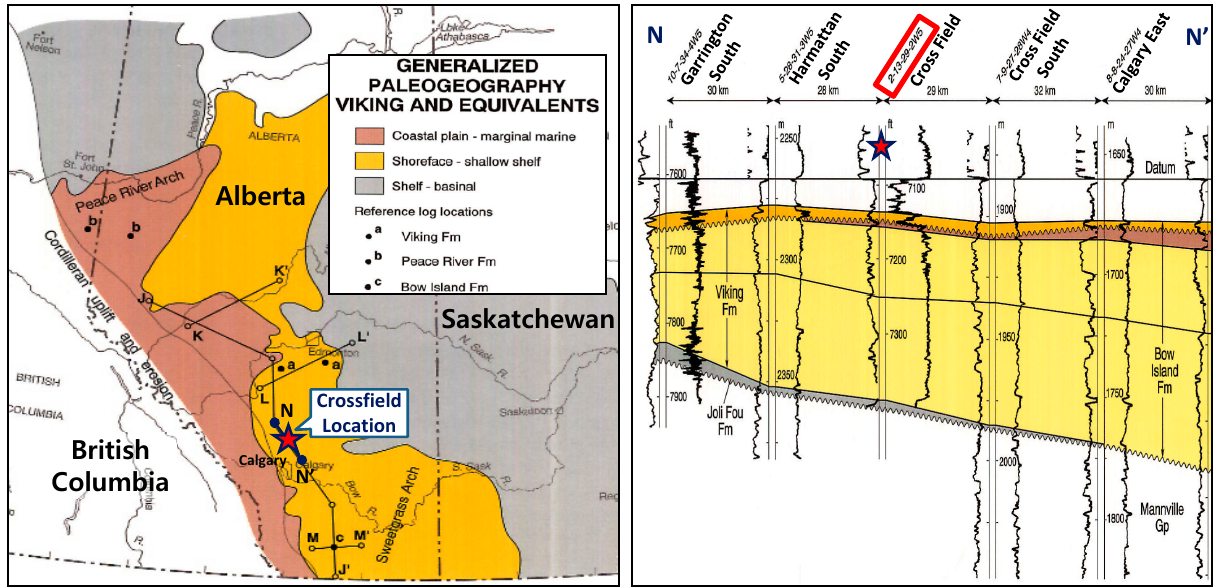
Figure 6. Regional Viking Geology in Western Canada Sedimentary